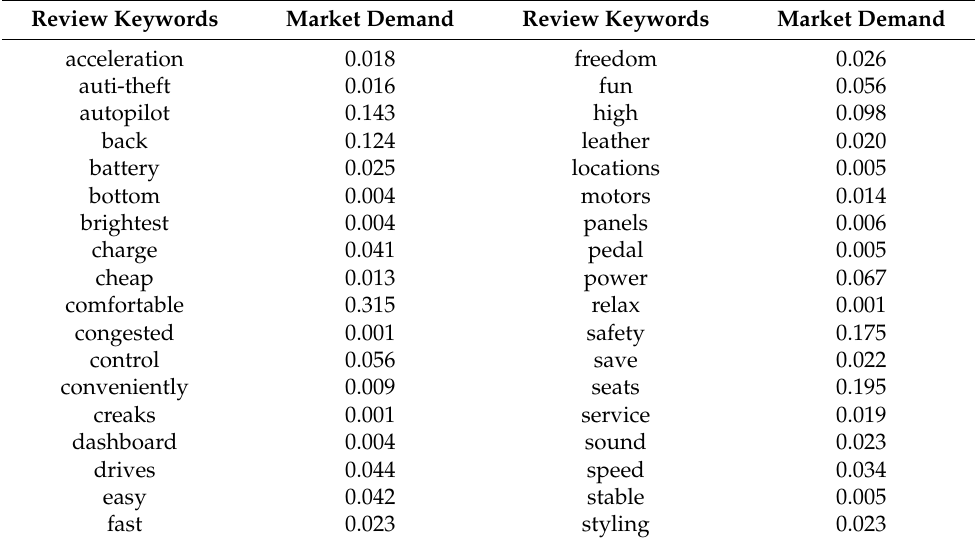
Table 7. Market demand indicator of review keywords in the EVs